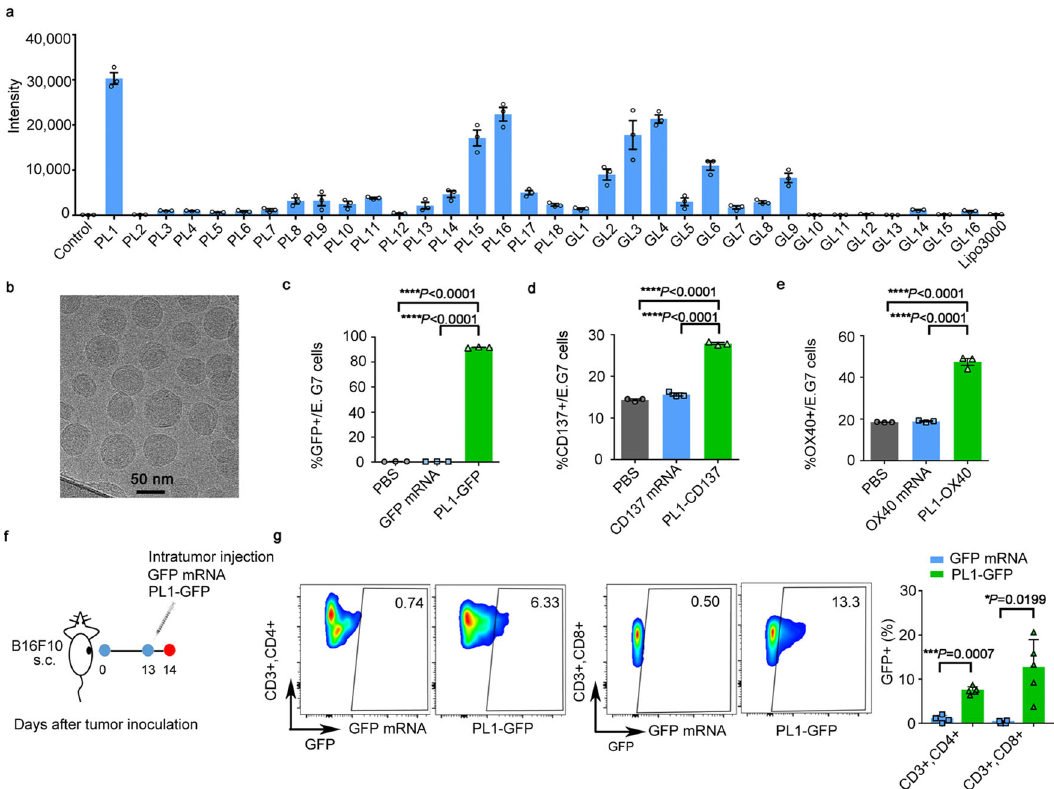
Fig. 2 Biomimetic phospholipid- and glycolipid-derived nanoparticles for mRNA delivery. a Luminescence intensity of phospholipid- (PL) and glycolipid- derived (GL) nanoparticles delivering fi re fl y luciferase (Fluc) mRNA to E.G7 cells. b Cryo-TEM image of PL1-mRNA nanoparticles (a representative image from one of fi ve independent fi elds of view in a single experiment). Scale bar = 50 nm. c PL1 nanoparticles delivered GFP mRNA to E.G7 cells. d PL1-CD137 induced CD137 expression in E.G7 cells. e PL1-OX40 induced OX40 expression in EG.7 cells. f Scheme of GFP expression in B16F10 tumors after a single injection of free GFP mRNA or PL1-GFP. g GFP expression in CD4 + , CD8 + T cells, after a single intratumoral injection with GFP mRNA ( n = 4) or PL1-GFP mRNA ( n = 5) in B16F10 tumors. Data in c , d and e are representative of three independent experiments. All data are presented as the mean ± S.E.M. Statistical signi fi cance in c , d , e was analyzed using one-way ANOVA followed by Dunnett ’ s multiple comparison test, and data in g was analyzed using the two-tailed Student ’ s t -test. * P < 0.05; *** P < 0.001; **** P < 0.0001. Source data are provided as a Source Data fi